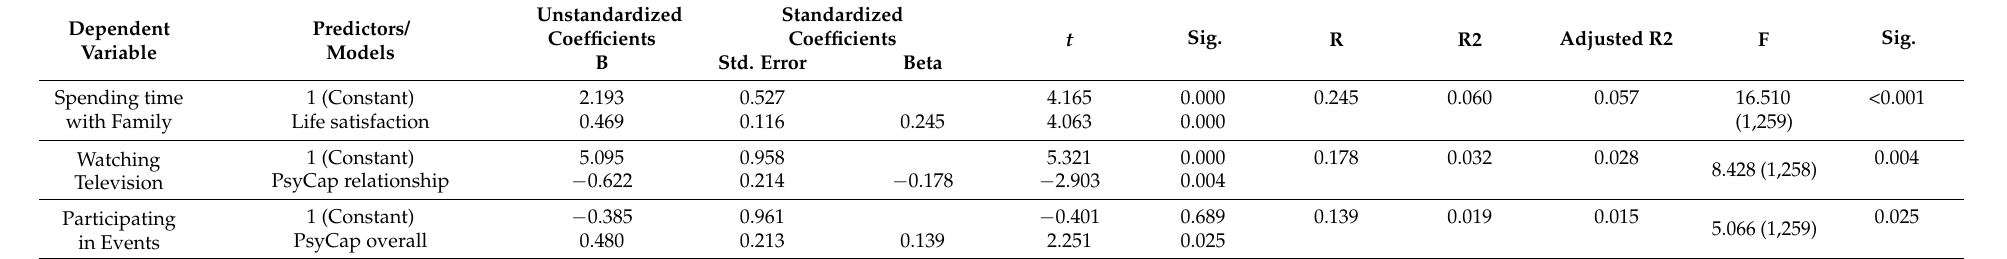
Table 16. Multiple regression model, the dependent variables are leisure preferences, and the predictors are life satisfaction, mindfulness, and psychological